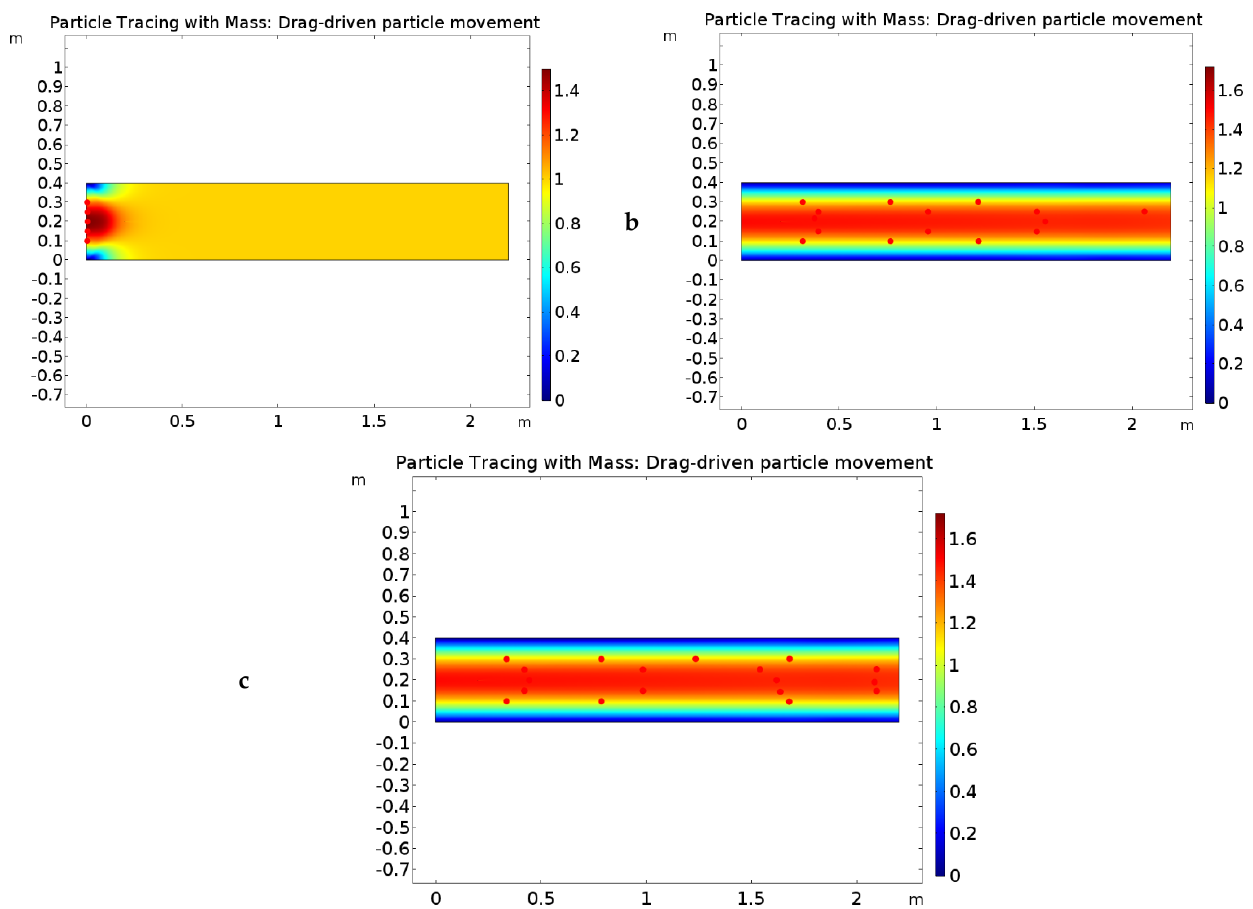
Figure 8. Regular particles movement within the polymer matrix as a function of time ( a – c ) for surface: velocity of particle tracing.